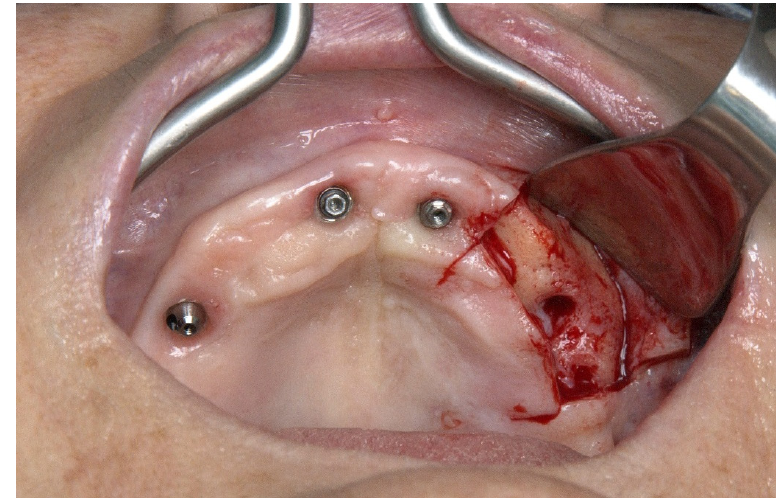
Figure 22. Perioperative photograph after flap opening.